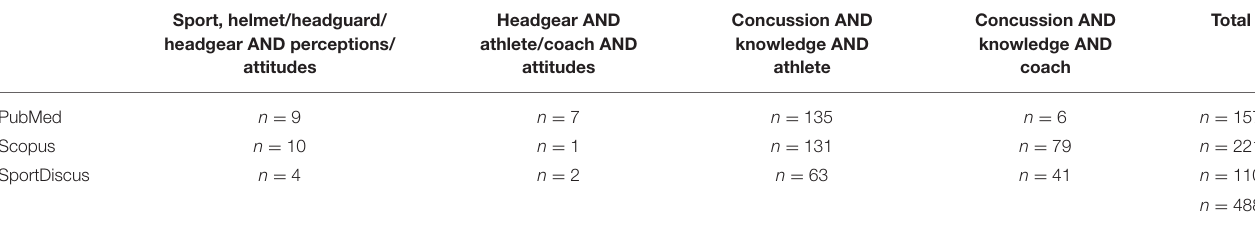
Concussion AND Headgear AND knowledge athlete/coach AND attitudes